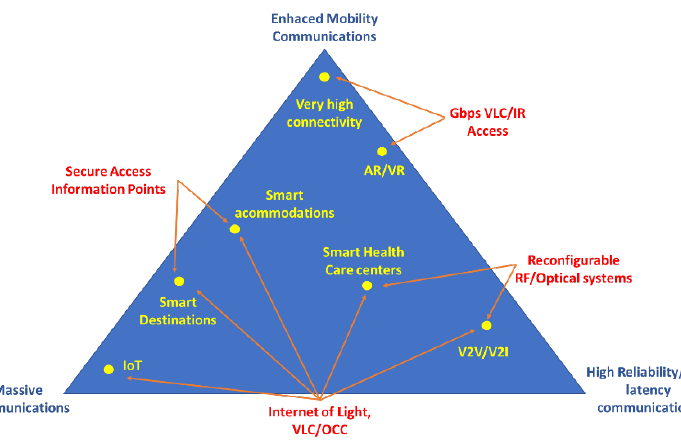
Figure 7. 6G VLC-based applications for the tourism industry.